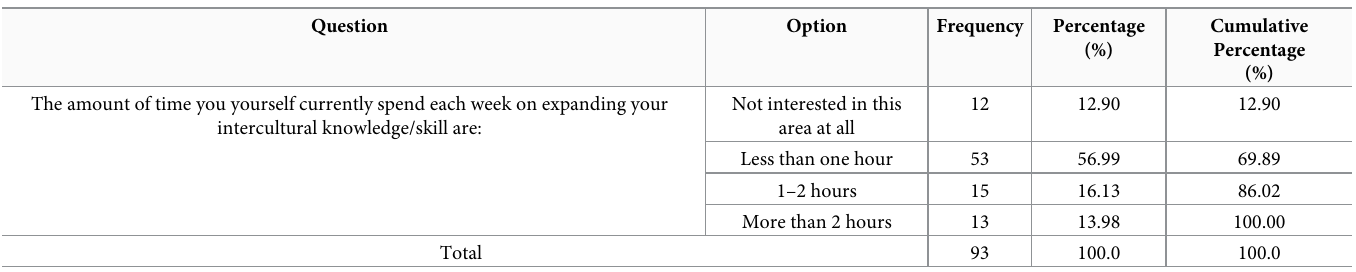
Table 6. Time devoted to self-improvement in intercultural knowledge/skills.